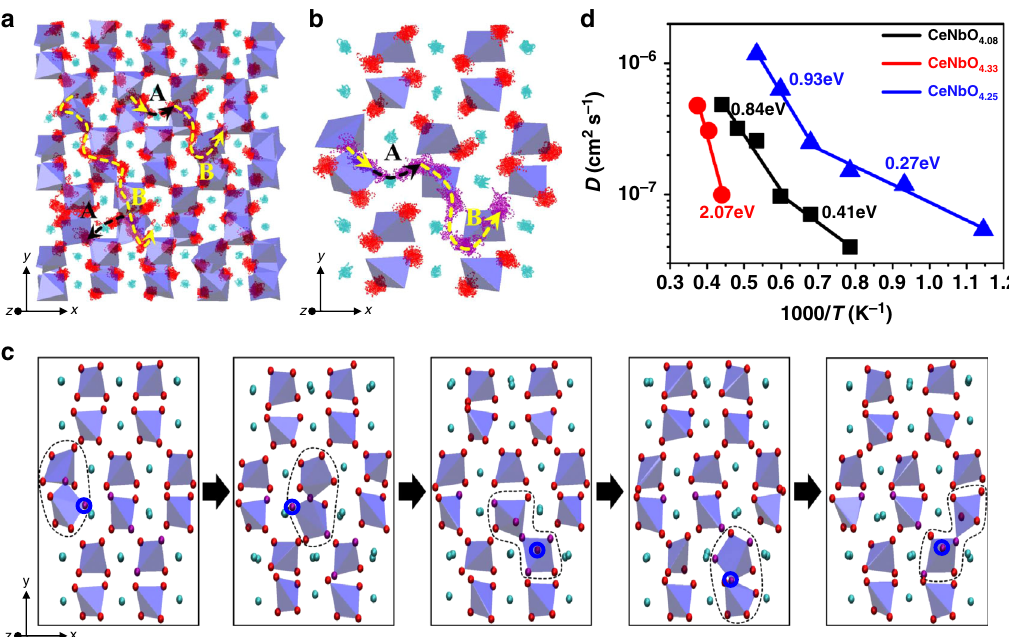
Fig. 6 The oxide ionic transport mechanism of CeNbO 4 + δ . a , b Trajectory scatter plots of Ce and O atoms showing the migration paths A (black dash dot line) and B (yellow dash dot line) with the NbO n polyhedral network embedded in, and c snapshots of long-range oxide ion (marked with the blue circle) migration involving the breaking and reforming of the Nb 2 O 9 units (highlighted by dashed lines) in CeNbO 4.08 from the MD simulations at 1200 °C. In order to illustrate the Nb 2 O 9 breaking and reforming mechanism clearly, in b , c the weak Nb-O bonds >2.2 Å are not included in the NbO n polyhedral units. d Arrhenius plot of the oxygen diffusion coef fi cient calculated using the MSD values of oxygen atoms for CeNbO 4 + δ ( δ = 0.08, 0.25, 0.33). The activation energies are